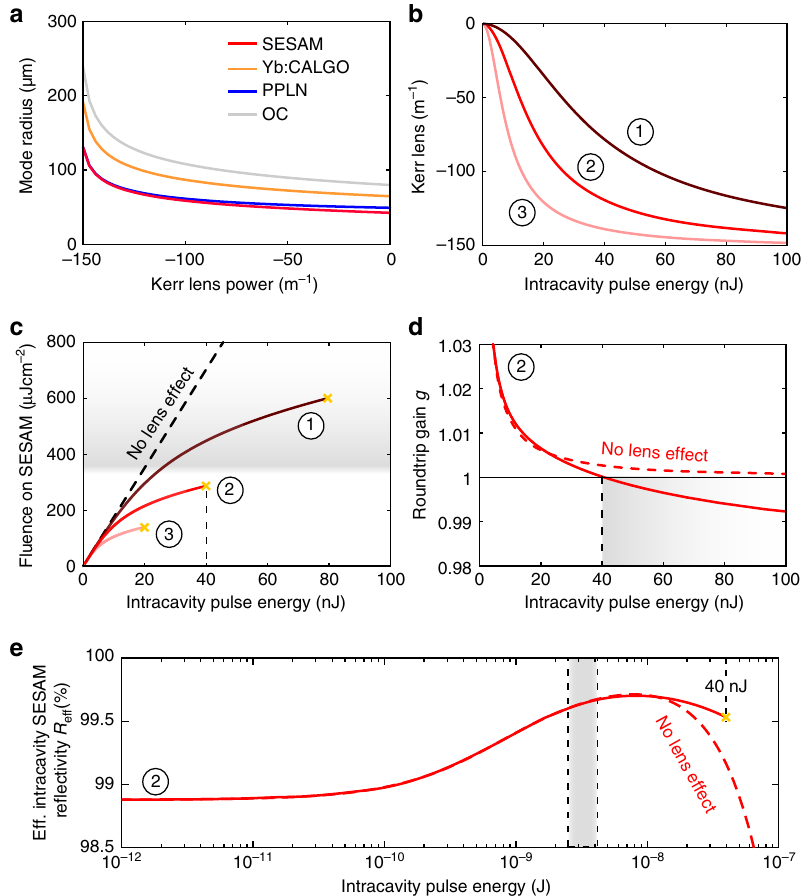
Fig. 5 Effect of the dynamic defocusing lens in the PPLN on various parameters. a Intracavity mode radius as function of PPLN Kerr lens power. b PPLN Kerr lens as function of intracavity pulse energy for the three different PPLN grating vector values K g of (1) 854 mm − 1 , (2) 889 mm − 1 and (3) 910 mm − 1 . At a wavelength of 1052 nm, these values correspond to effective nonlinear indices n 2,eff of (1) − 0.99 × 10 − 18 m 2 W − 1 , (2) − 2.07 × 10 − 18 m 2 W − 1 and (3) − 4.24 × 10 − 18 m 2 W − 1 , respectively c Fluence on the SESAM with and without the effect of the defocusing lens. The grey shaded area corresponds to the region where damage of the SESAM is likely to occur. d Gain g (ratio of input intensity to output intensity after two passes through the gain crystal) as a function of intracavity pulse energy. Solid line: with lens effect; dashed line: assuming a constant mode size in the Yb:CALGO. Above a certain intracavity pulse energy (grey area), no more gain is experienced by the pulses. e Effective intracavity SESAM re fl ectivity for PPLN position (2): for each pulse energy, the corresponding change in mode size and pulse duration is taken into account. The experimentally observed cw modelocking region from 2.4 to 4 nJ is shaded in grey